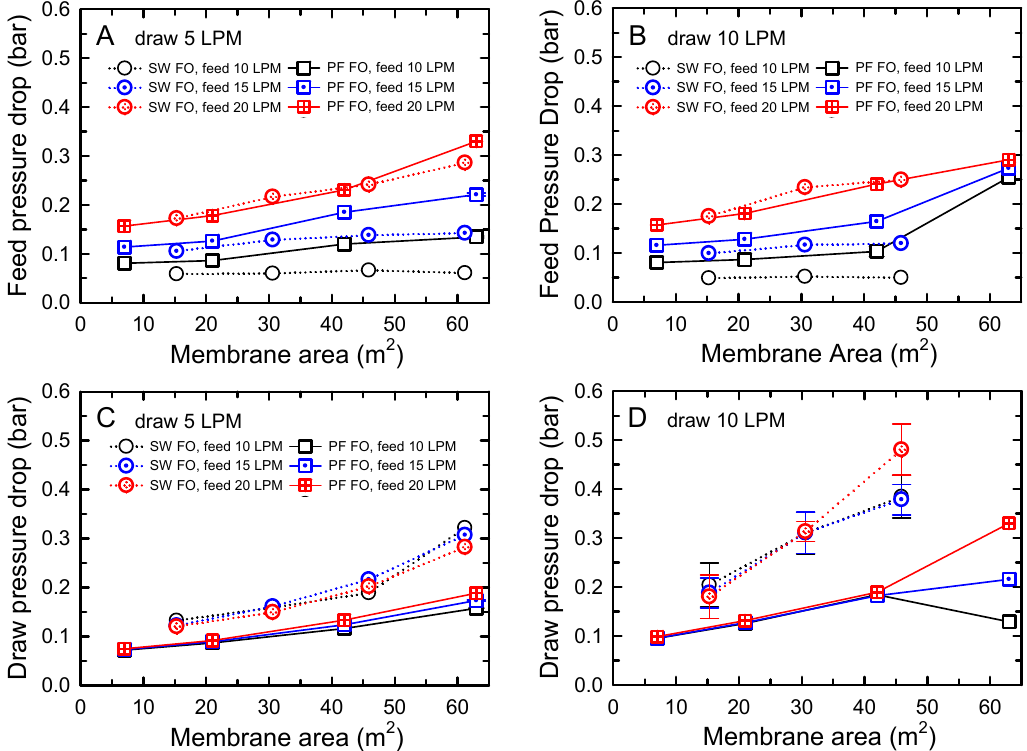
Figure 4. Comparisons of pressure drops in the feed ( A , B ) and draw ( C , D ) channels of spiral-wound (SW) and plate-and-frame (PF) forward osmoses (FO) as a function of membrane area. The applied draw solution (DS) flow rates were 5 ( A , C ) and 10 LPM ( B , D ). The feed solution (FS) flow rates were varied from 10 to 20 LPM. The membrane areas were adjusted by a serial connection of FO elements: 1–4 elements of SW FO and 1, 3, 6, and 9 elements of PF FO. The concentrations of FS and DS were 10 and 70 g/L, respectively.